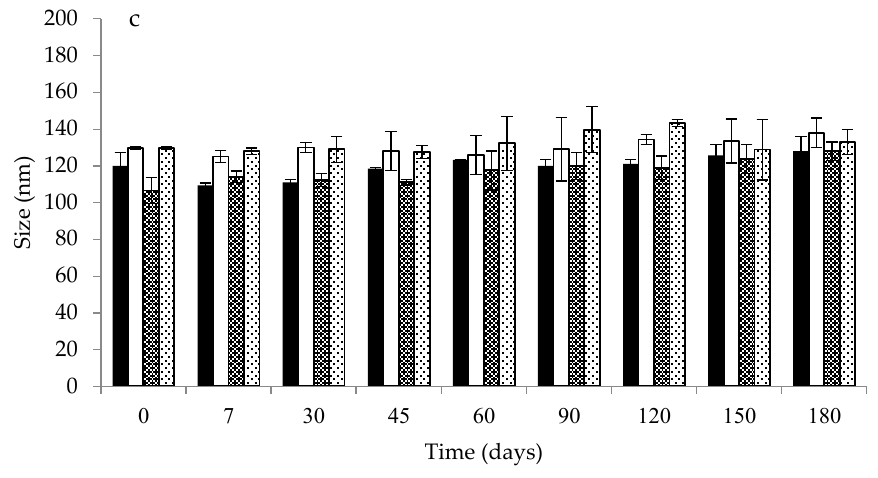
Figure 4. Size variation in unloaded and loaded microemulsions M1 ( a ), M2 ( b ) and M3 ( c ) during 180 days of storage at +4 – 8 °C and +25 °C. Data are expressed as means ± SD, n = 3.